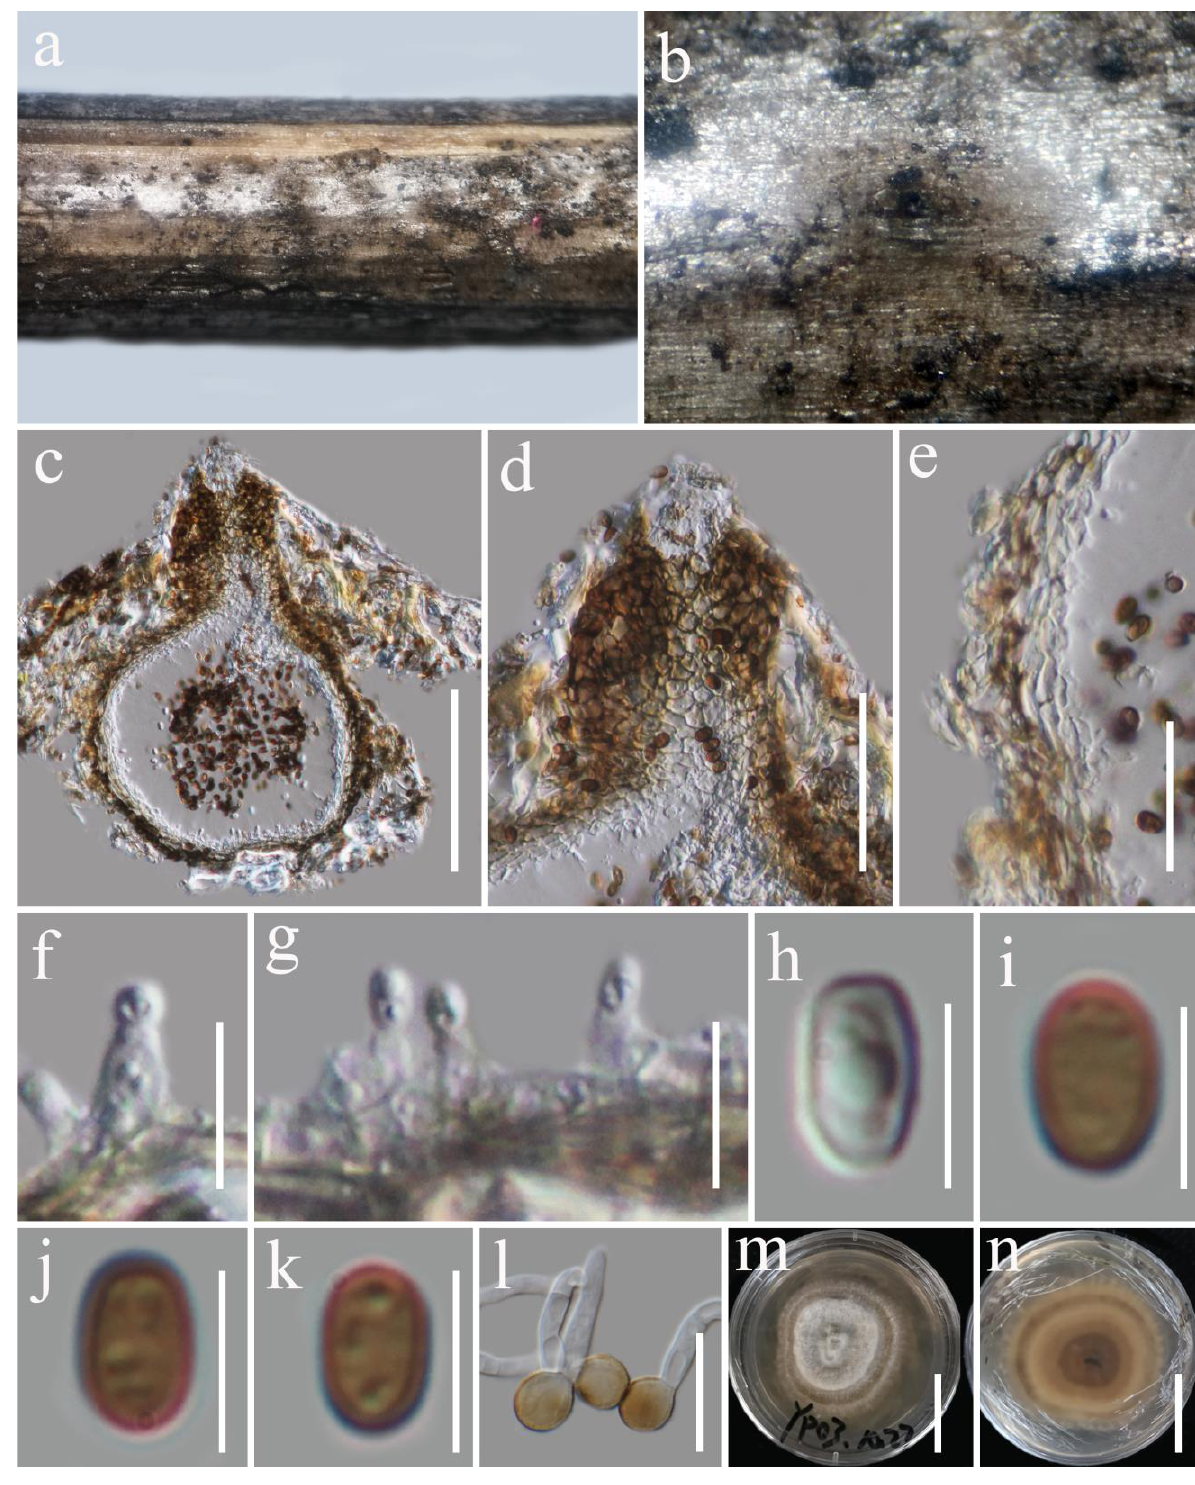
Figure 3. Austropleospora archidendri (MFLU 22-0042). ( a , b ) Conidiomata on the natural wood surface; ( c ) section through a conidioma; ( d ) ostiolar neck; ( e ) pycnidial wall; ( f , g ) conidiogenous cells and developing conidia; ( h – k ) conidia; ( l ) germinated conidia; ( m , n ) culture characters on PDA (n from the bottom). Scale bars, ( c ) 100 μm; ( d ) 50 μm; ( e ) 25 μm; ( f , g , l ) 10 μm; ( h – k ) 5 μm; ( m , n ) 30 mm.